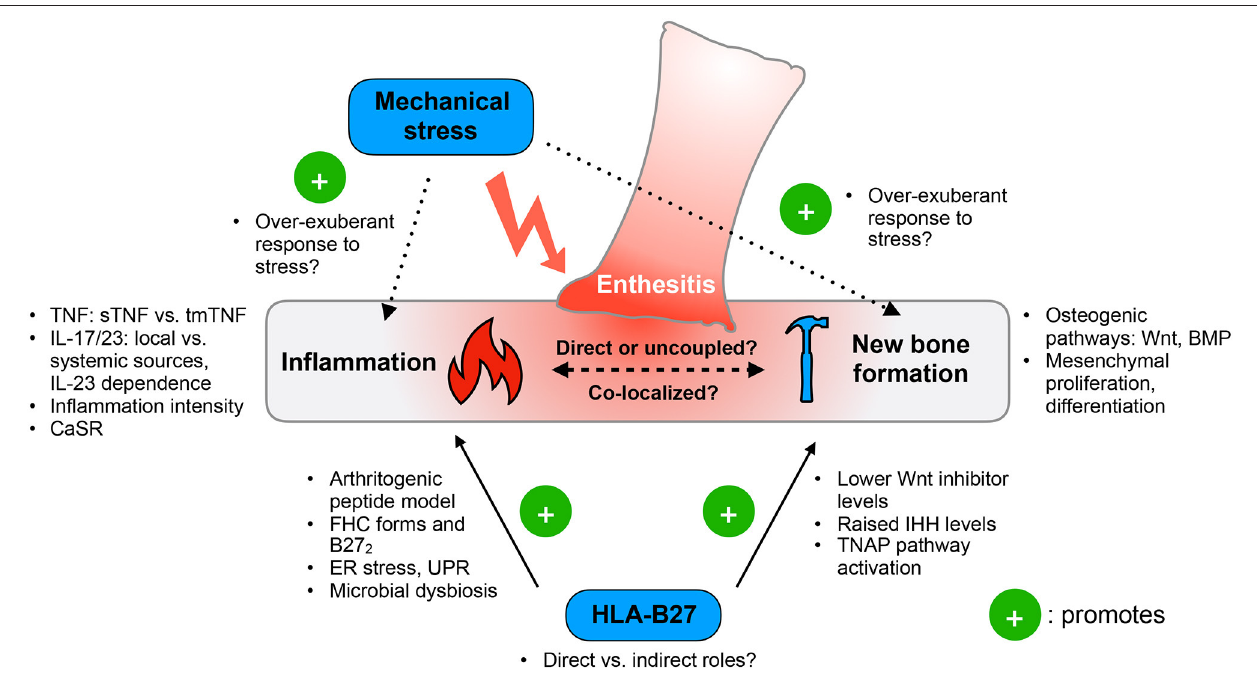
FIGURE 1 | Functional model of ankylosing enthesitis in JSpA. Enthesitis is primarily driven by the tumor necrosis factor (TNF) and IL-17/23 pathways. Inflammation appears to influence osteoproliferation by acting on the Wnt and BMP pathways, as well as controlling mesenchymal proliferation and differentiation. The intensity of inflammation may determine the switch between bone loss and formation. However, it is still unclear if inflammation and pathologic new bone formation are directly linked or uncoupled. Mechanical stress has emerged as an important trigger of disease, yet the exact molecular mechanisms are unknown. HLA-B27 may contribute to both inflammation and pathologic new bone formation, but how crucial this genetic risk factor is to JSpA pathogenesis remains to be clarified. sTNF, soluble TNF; tmTNF, transmembrane TNF; CaSR, calcium sensing receptor; FHC, free heavy chain; B272, HLA-B27 homodimers; ER, endoplasmic reticulum; UPR, unfolded protein responses; Wnt, Wingless-related integrated site; IHH, Indian hedgehog; TNAP, tissue non-specific aminopeptidase; BMP, bone morphogenetic